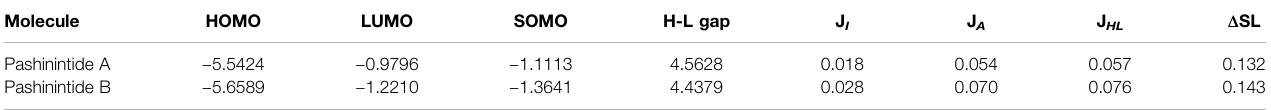
TABLE 9 | HOMO, LUMO and SOMO orbital energies, HOMO-LUMO gap and the KID descriptors (all in eV) tested in the veri fi cation of the Koopmans-like behavior of the MN12SX/Def2TZVP/H2O model chemistry for the Pashinintides A and B. Molecule HOMO LUMO SOMO H-L gap J I J HL Δ SL